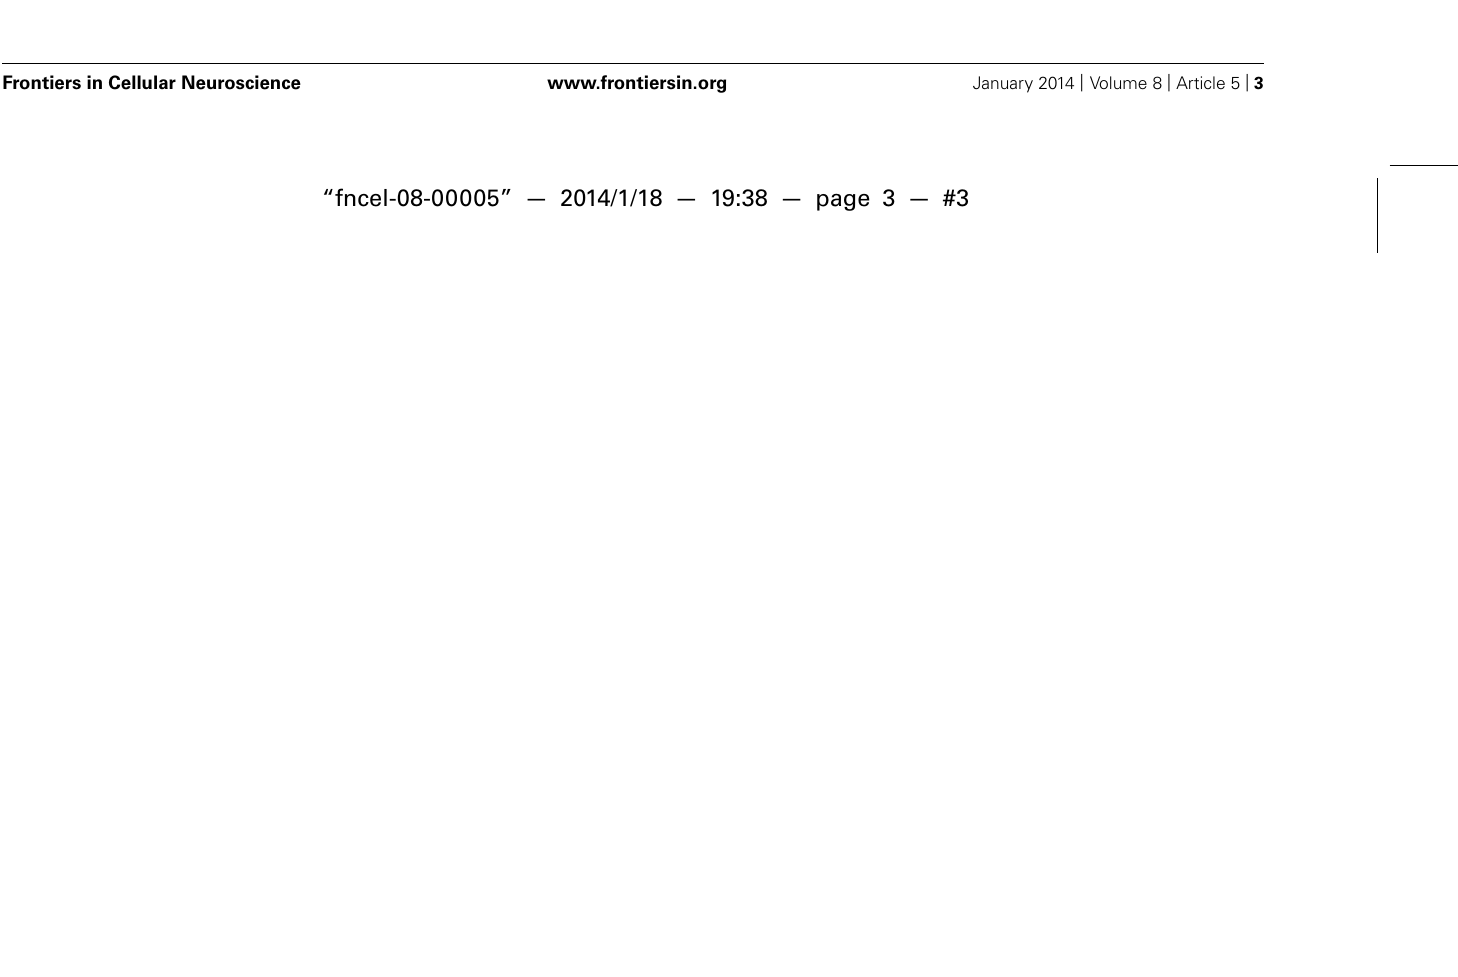
The largest PGC-SWE (Ripke etal., 2013) in the form of summary statistic p-values was obtained from public access website (https://pgc.unc.edu/). For each gene ( ± 100 kb from 5 (cid:2) and 3 (cid:2) ends of gene), the strongest P value association is provided in the “PGC-SWE P” column.The “Rank” column indicates the ranking of the illustrated genes based on the strength of association with the schizophrenia GWAS data